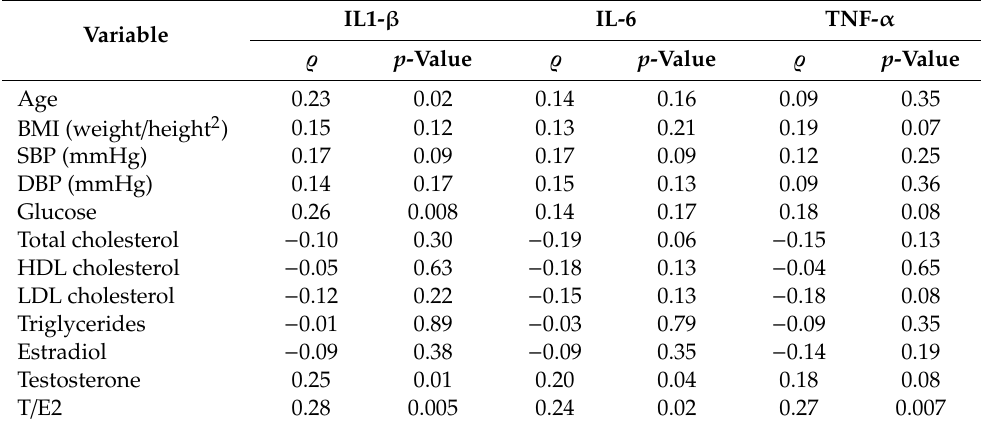
Table 2. Correlation between proinflammatory cytokines and clinical / hormonal variables in the entire cohort.